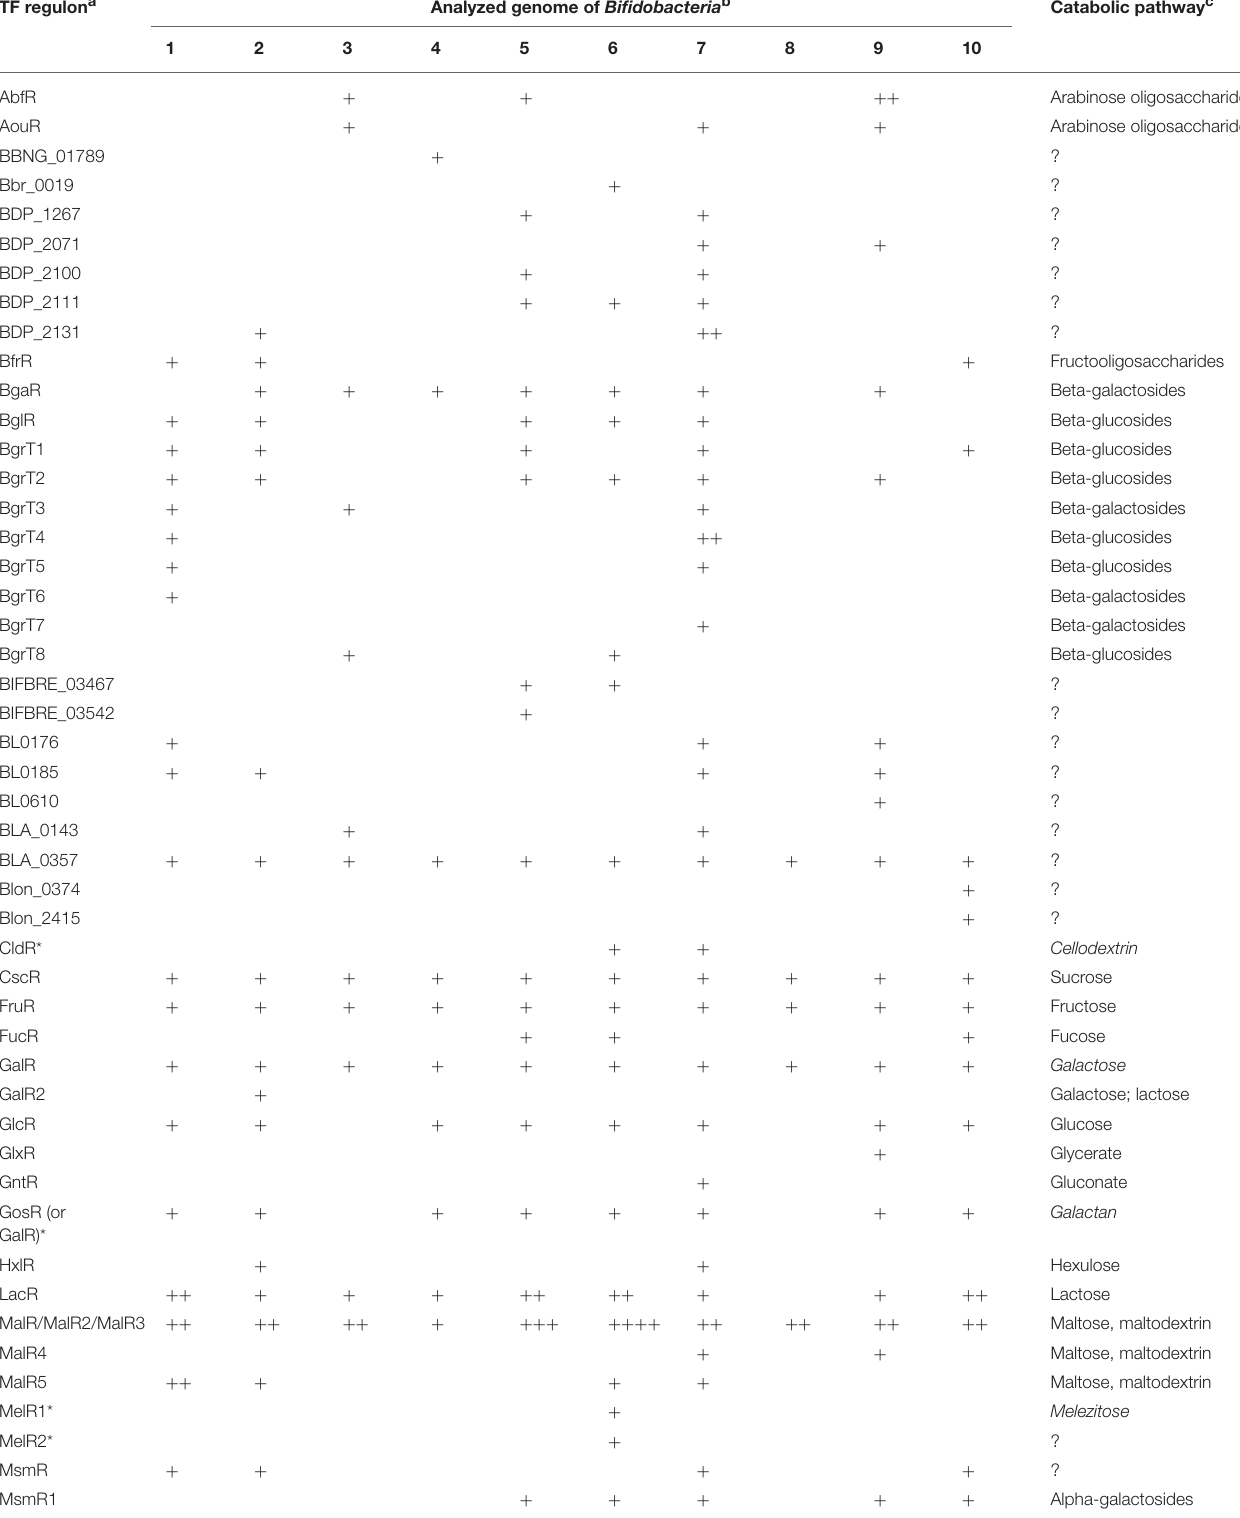
TABLE 2 | Composition of orthologous groups of sugar catabolic TFs with reconstructed regulons in 10 bifidobacterial genomes. TF regulon